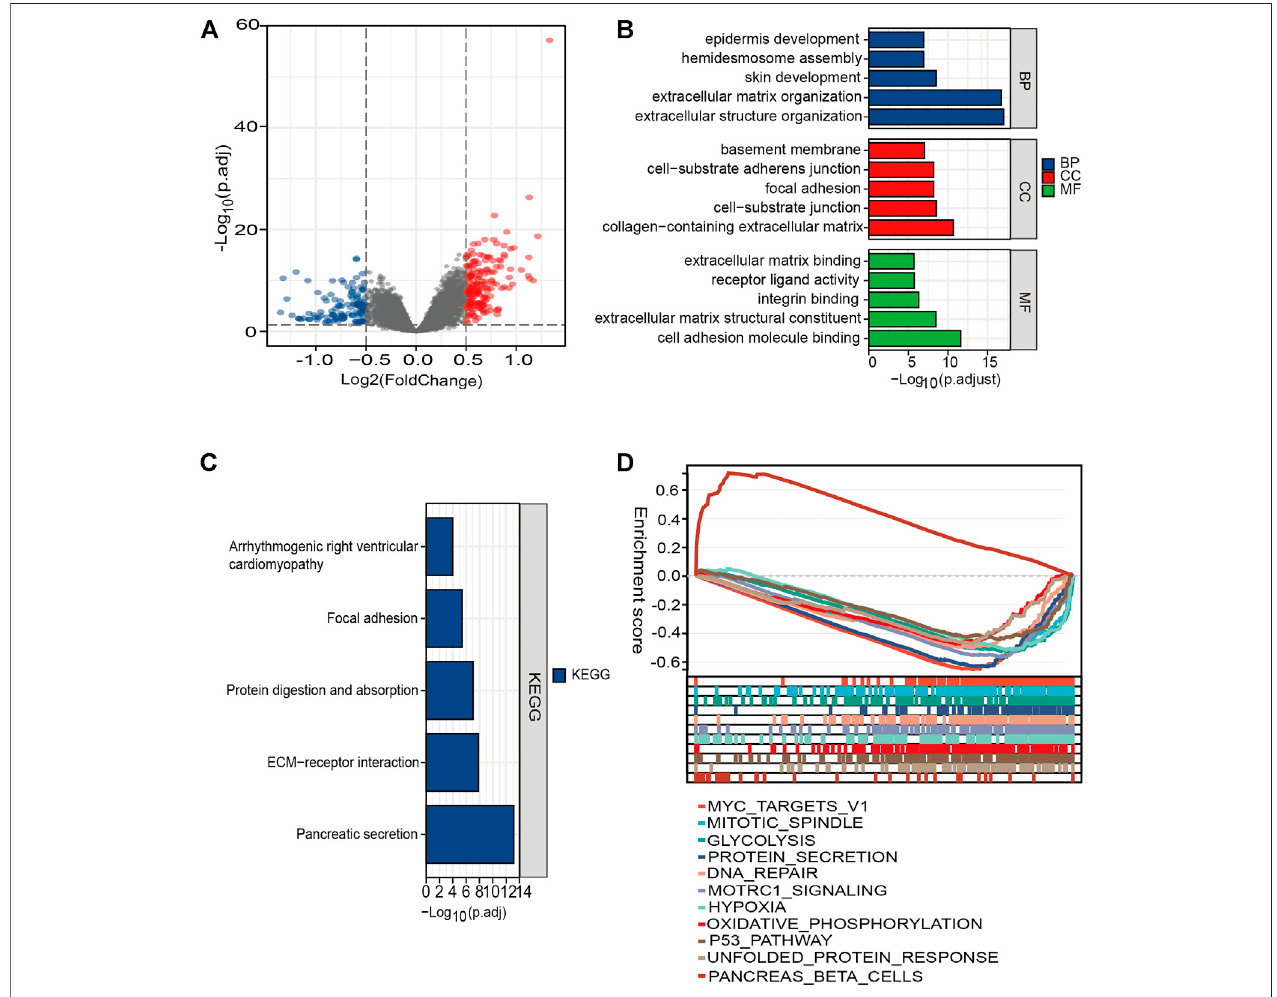
FIGURE 7 | Functional enrichment analysis of the DEGs between different risk groups. (A) Volcano plot of genes. Blue dots represent downregulated expressed genes, while red dots represent upregulated expressed genes. (B) Top fi ve classes of GO enrichment terms for genes in biological process (BP), cellular component (CC), and molecular function (MF). (C) Meaningful KEGG enrichment terms among genes. (D) Enriched gene sets in high- and low-risk groups by